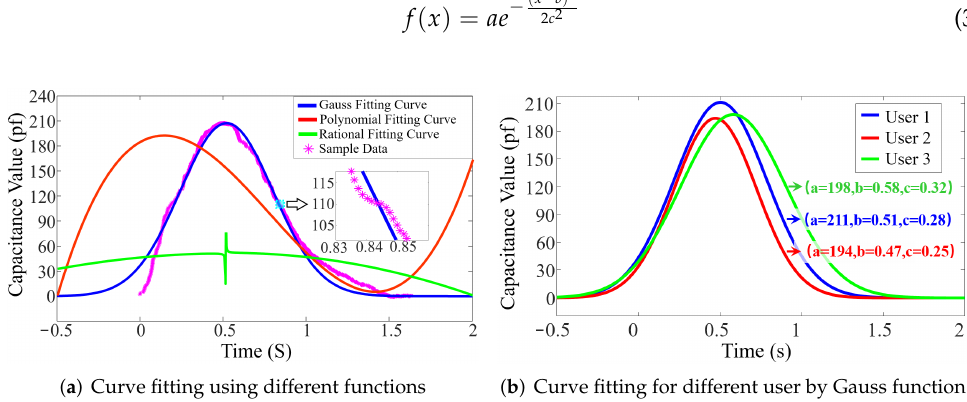
Figure 4. ( a ) Curve fitting base on different functions. ( b ) Gauss function fitting for three